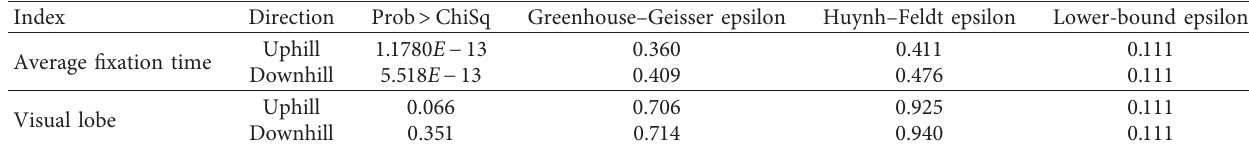
Table 4: Mauchly’s test of sphericity and evaluation of epsilon (one-way repeated measures ANOVA).